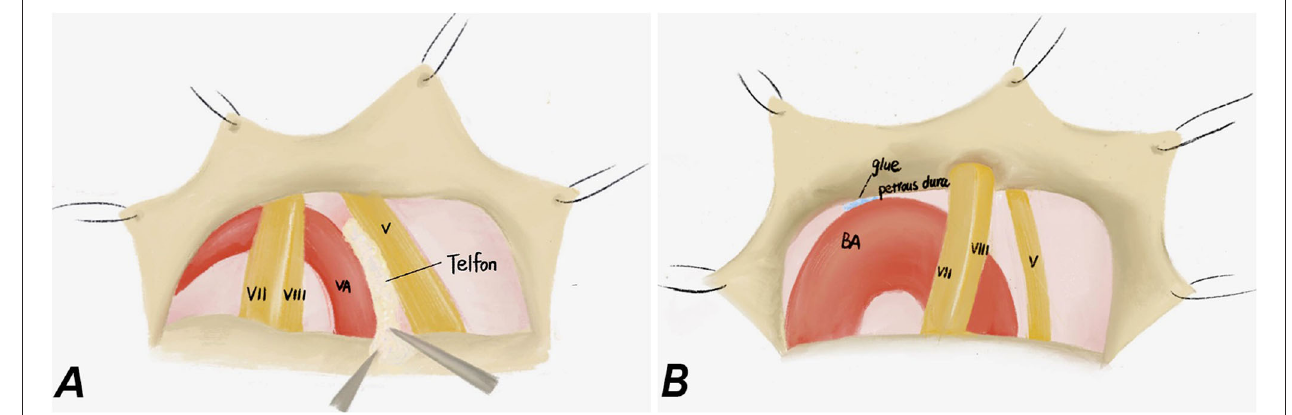
FIGURE 1 | Intraoperative pictures of intervention method and transposition method. (A) Intervention method: the Teflon felt was inserted between the trigeminal nerve and VA. (B) Transposition method: the BA was fixed on the nearby petrous dura mater by using biological glue and a space was created between the trigeminal nerve and the